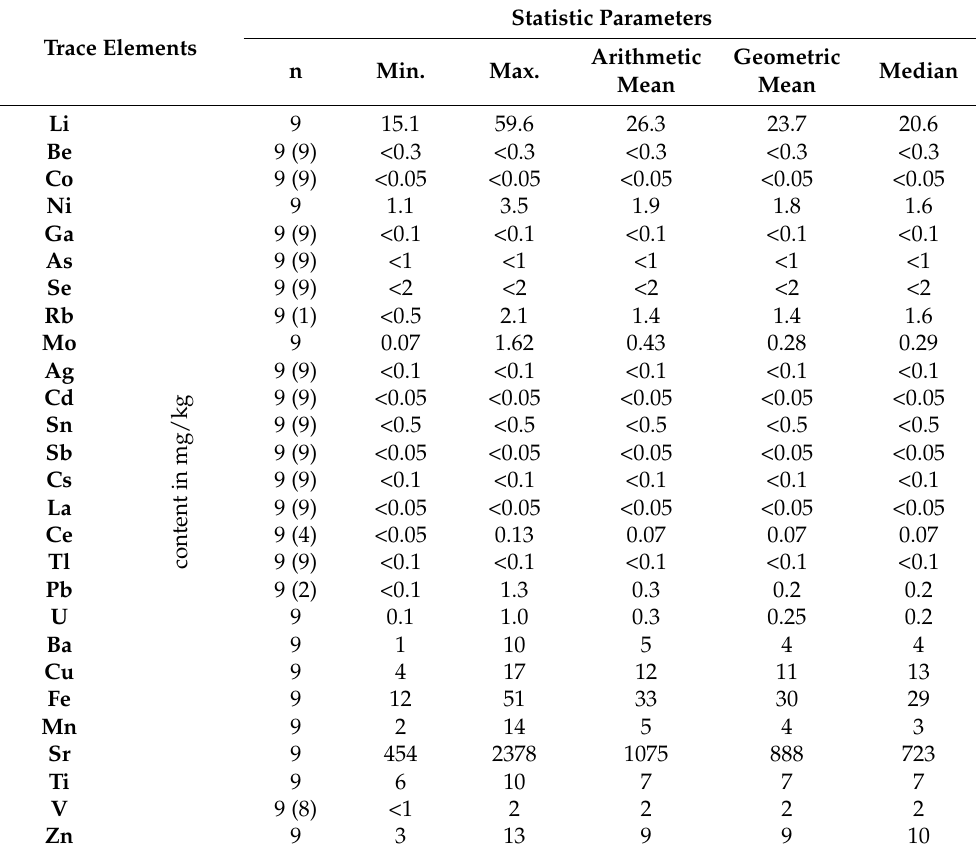
Table 5. Statistic parameters of trace element content in the sulphate potash-bearing deposits (poly- halites) of PZ1 cyclothem in